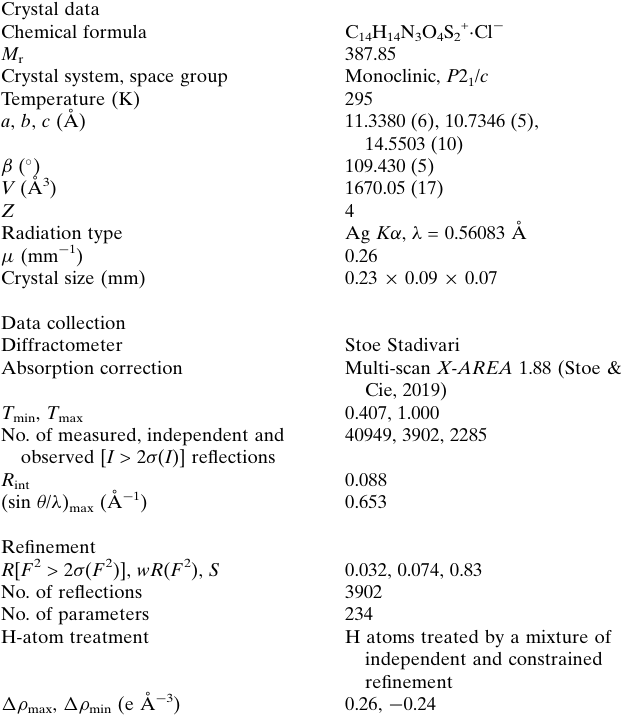
Table 2 Experimental details. Crystal data Chemical